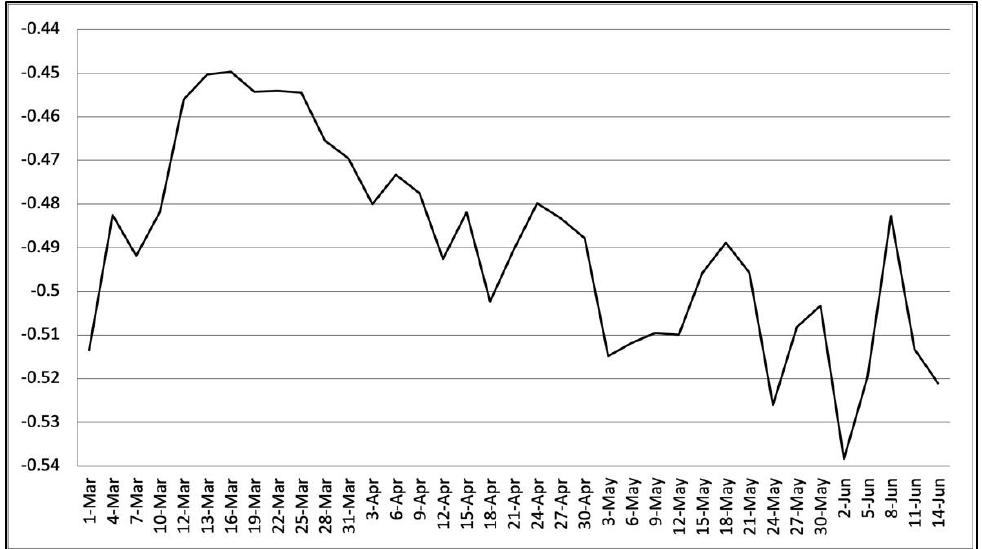
Figure 3. Overall sentiments of the population regarding COVID-19 from 1 March 2020, to 14 June 2020. The vertical axis indicates the overall sentiment score of each collection day, while the hori- zontal axis shows the collection